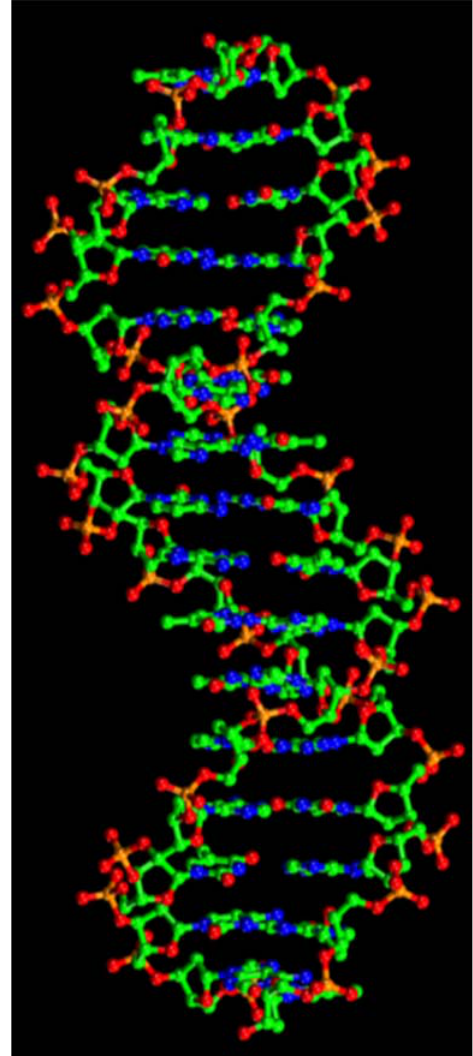
Figure 1. Self-assembled double helix DNA